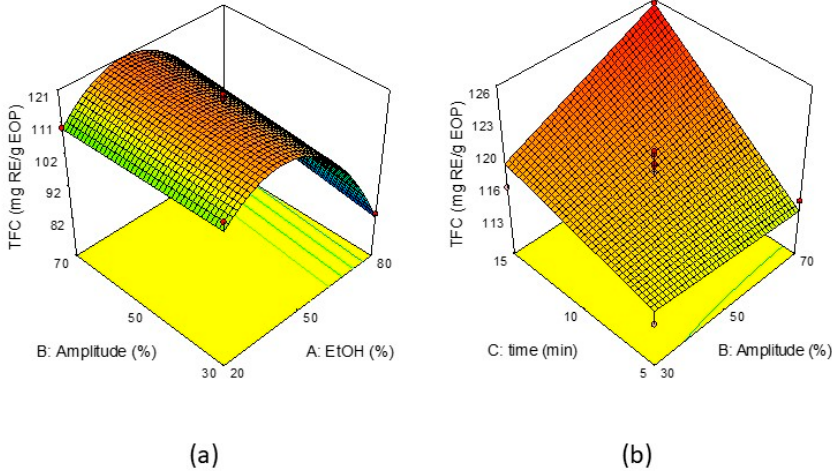
Figure 3. Response surface plots of the total flavonoid content (TFC) as a function of (a) the ethanol concentration andamplitude (time: 10min) and( b ) theamplitude andtime (ethanolconcentration: concentration and amplitude (time: 10 min) and (b) the amplitude and time (ethanol concentration: 50%).